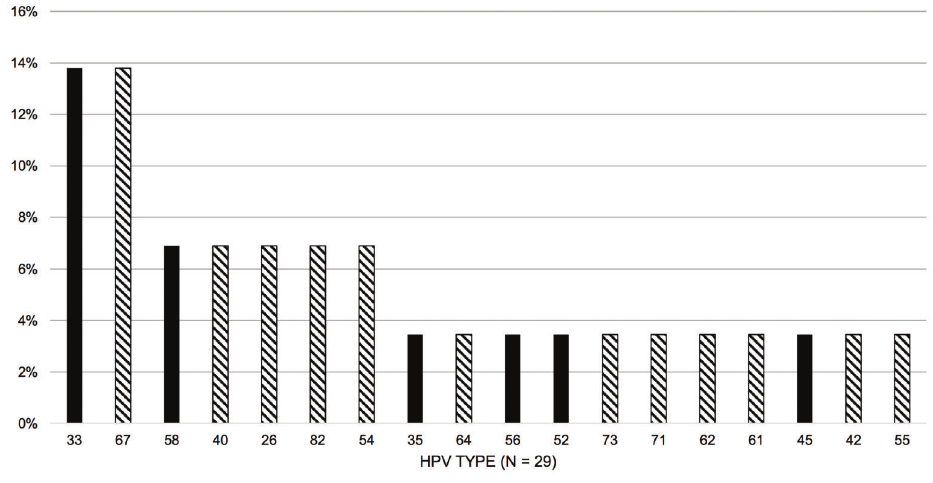
Figure 1. Human papillomavirus type prevalence of SOLCA-Guayaquil tongue cancer cohort (2006 – 2011). HPV: human papillomavirus; Solid black color: high-risk HPV; Diagonal pattern: low risk HPV. SOLCA: Sociedad de Lucha contra el Cancer.